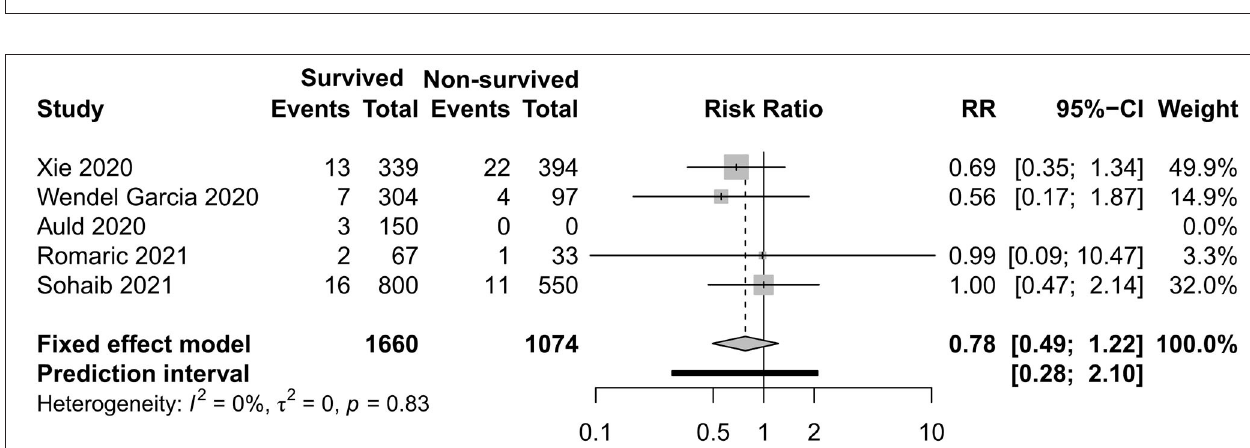
FIGURE 10 | Risk ratio of invasive mechanical ventilation between survived and non-survived patients.